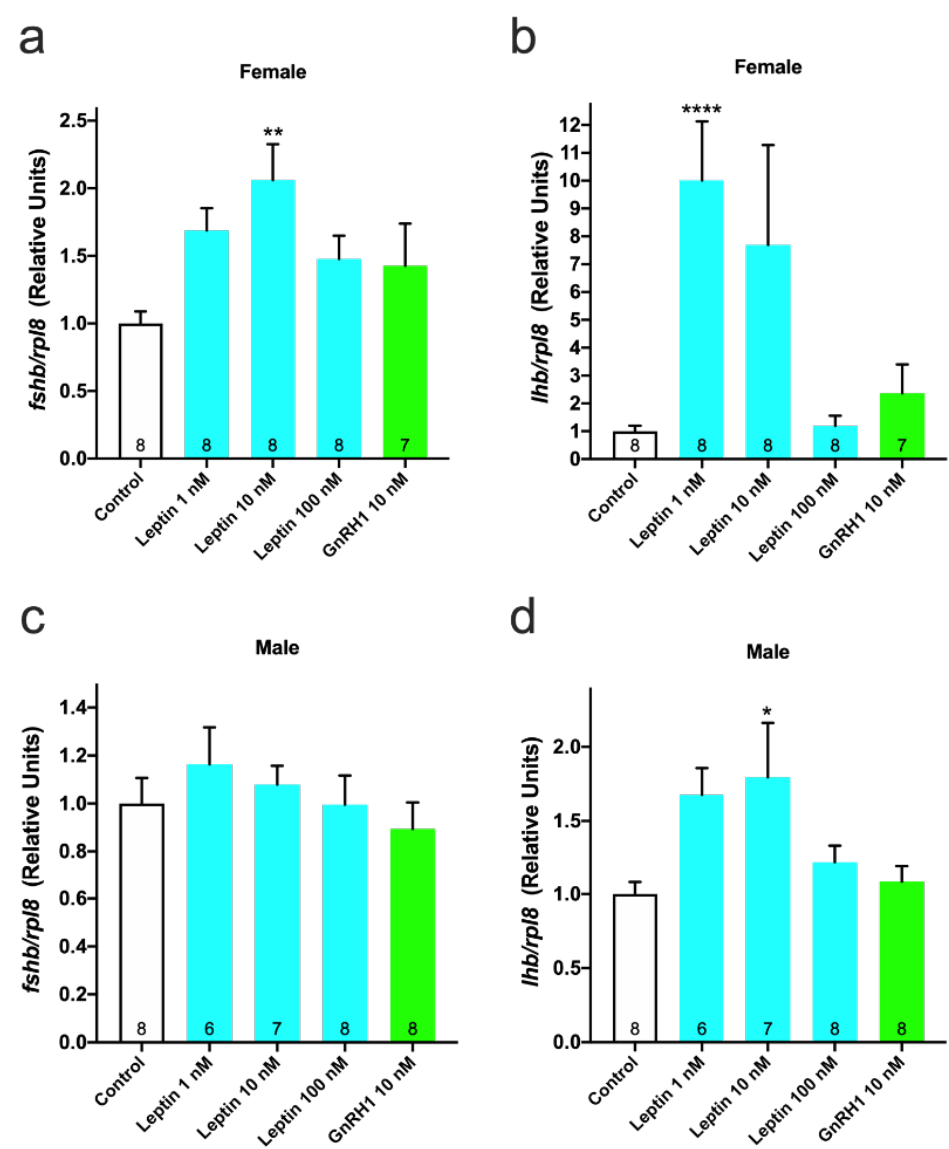
Figure 4. In vitro effect of leptin on GTH gene expression in primary pituitary cells. Cells were treated with graded concentrations of leptin for 1 h. ( a ) fshb and ( b ) lhb expression in females and ( c ) fshb and ( d ) lhb expression in males. Data represented the mean ± SEM and were analyzed by one-way ANOVA, followed by a Dunnett’s multiple comparison test (vs. control group). The number at the bottom of the column indicates the number of samples. * p < 0.05, ** p < 0.01, **** p <